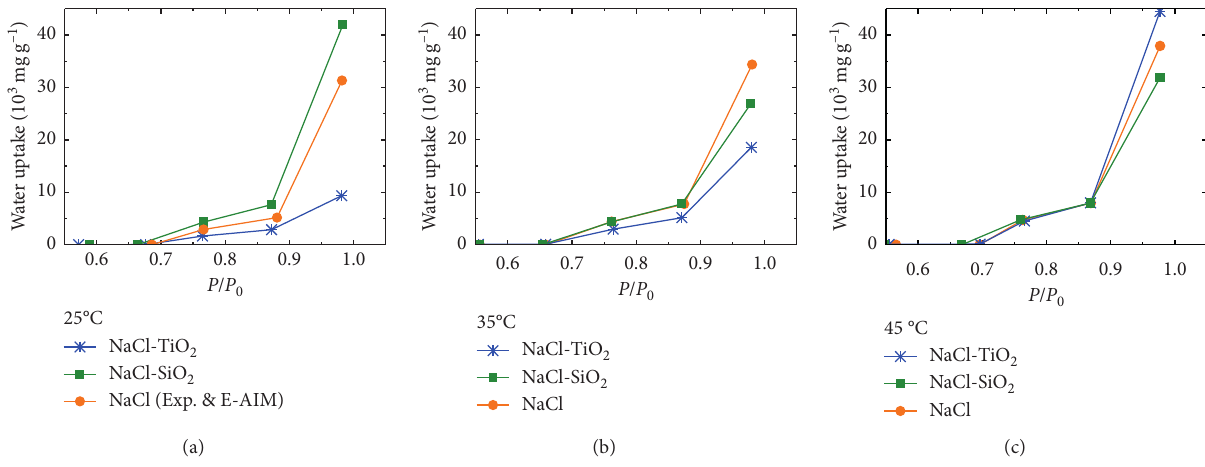
Figure 11: Comparison of isotherms of NaCl, NaCl-TiO ° C, (b) 35 ° C, and 2 , and NaCl-SiO 2 , at high relative pressure from 0.7 to 1 at (a) 25 (c) 45 ° C. The isotherm of NaCl at 25 ° C includes the experimental data and the correction as per the E-AIM model after the hygroscopic point as shown in Figure 9(a). Table 1: Measured specific surface area of NaCl, NaCl-TiO ° C, 35 ° C, and 45 ° C. 2 , and NaCl-SiO 2 at 25 Material